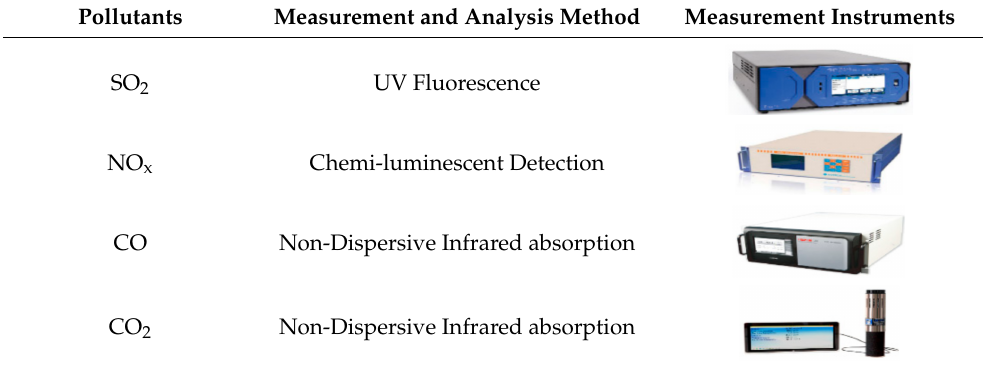
Table 1. SO 2 , NO 2 , CO, and CO 2 measurement methods and instruments. Pollutants Measurement and Analysis